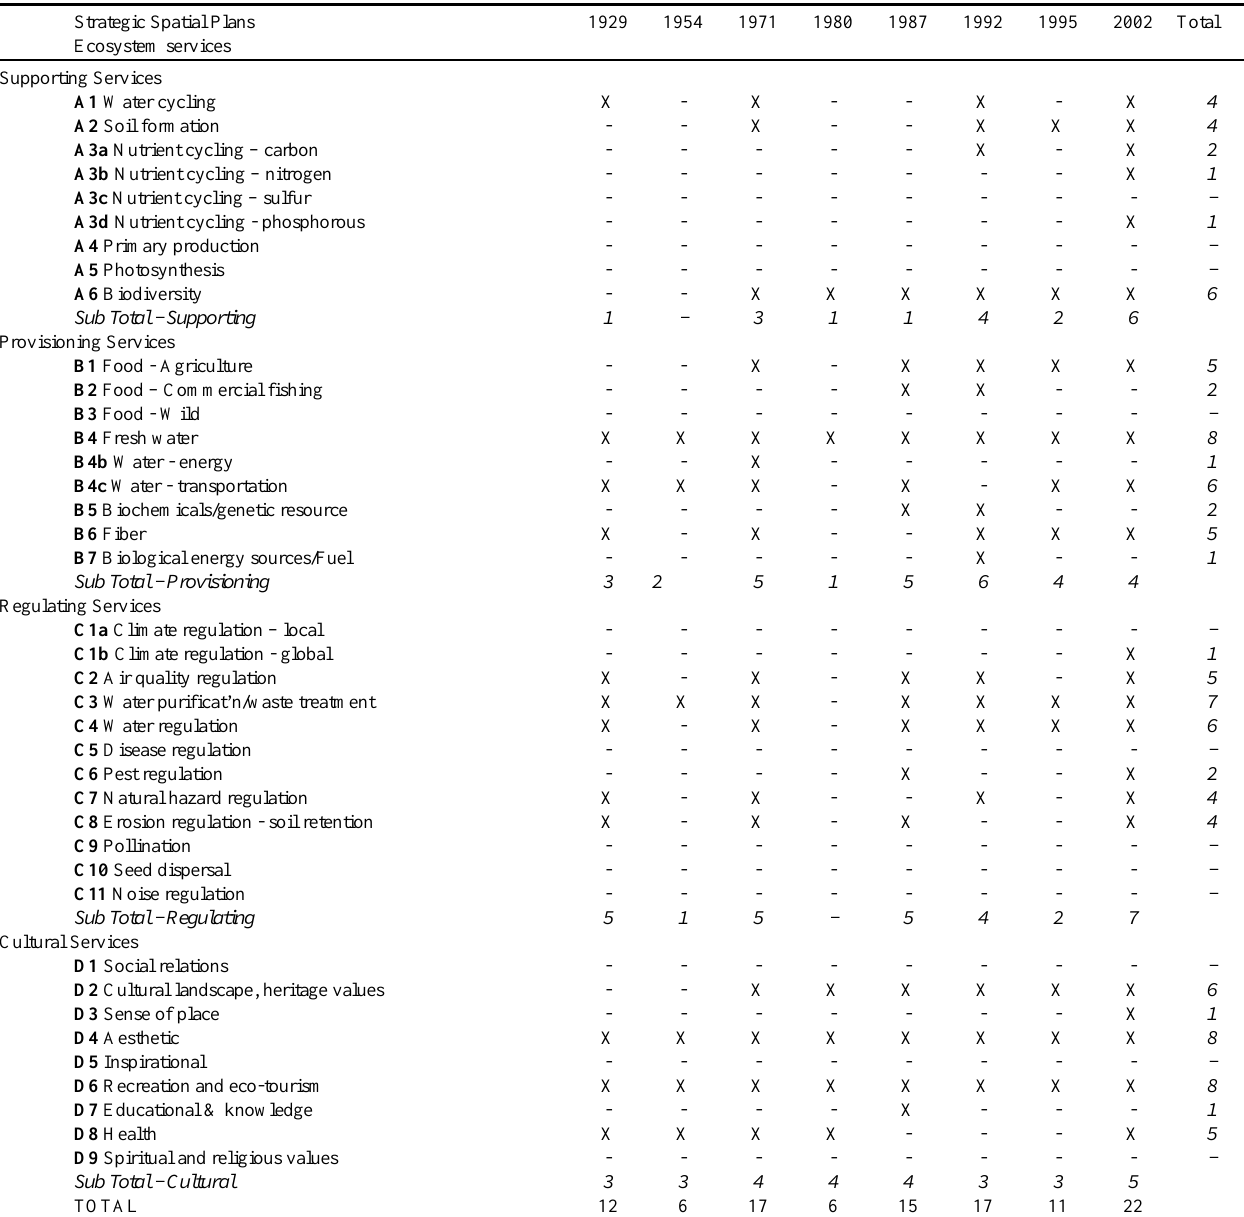
Table 3 . Ecosystem services addressed in Melbourne’s strategic spatial plans Strategic Spatial Plans Ecosystem